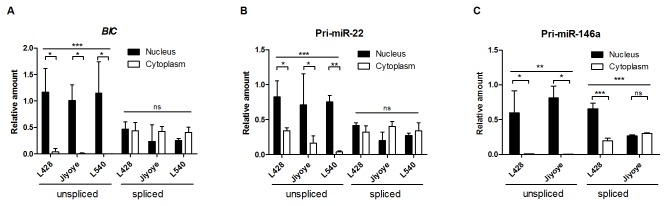
Cellular localization of unspliced and spliced pri-miRNA transcripts.(A) Unspliced BIC transcript levels were significantly higher in the nucleus than in the cytoplasm, whereas spliced BIC transcripts showed similar levels. (B) Unspliced pri-miR-22 transcripts were more abundant in the nucleus than in the cytoplasm and spliced pri-miR-22 transcript levels were similar. (C) Unspliced pri-miR-146a transcripts were almost exclusively in the nucleus, and spliced pri-miR-146a transcripts were both in the nucleus and in the cytoplasm. Unspliced and spliced pri-miR-146a transcripts were not detectable in L540 cells. Levels of pri-miRNA transcripts in the nucleus or the cytoplasm were calculated relative to their levels in the total fraction and corrected for the amount of RNA per cell. Average of three independent experiments was presented. Significance was calculated using 2-way ANOVA and Bonferroni posttest (* p<0.05, ** p<0.01, *** p<0.001, **** p<0.0001, ns - not significant).